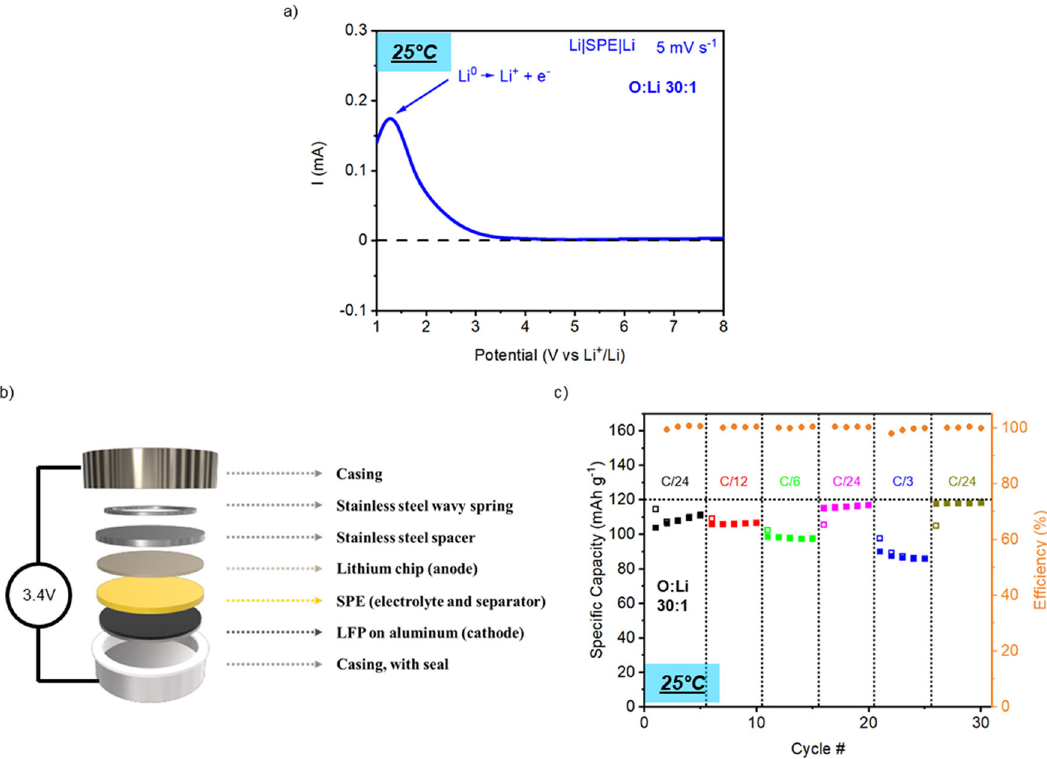
Fig. 7 Electrochemical testing of the PEO90PO10 solid polymer electrolyte (SPE) at 25 °C. a Linear sweep voltammetry (LSV) curve obtained for the PEO90PO10 SPE with O:Li ratio of 30:1, between 2 lithium electrodes, from 1 to 8 V at a scan rate of 5 mV s − 1 . b Schematic description of the battery. c Speci fi c capacities (black axis and square data) and coulombic ef fi ciencies (orange axis and orange round data) of the batteries are presented for each cycle, for both charge (hollow symbols) and discharge (full symbols), with colors corresponding to various C-rates (C/24 in black, C/12 in red, C/6 in light green, C/24 (2nd time) in magenta, C/3 in blue, and C/24 (3rd time) in